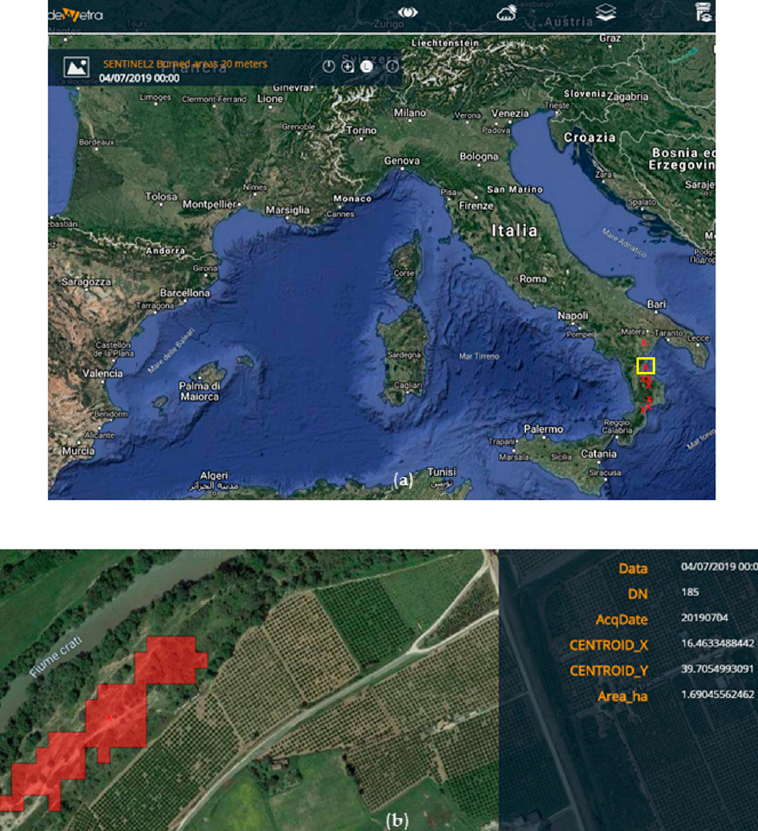
Figure 7. Map of burned areas for the Italian territory generated by AUTOBAM for the S2 acquisition performed on July 4th, 2019; ( a ) synoptic view; ( b ) zoom on one of the burned areas (highlighted by the yellow box in panel (a)) with the information about the burned area available for the end-user.